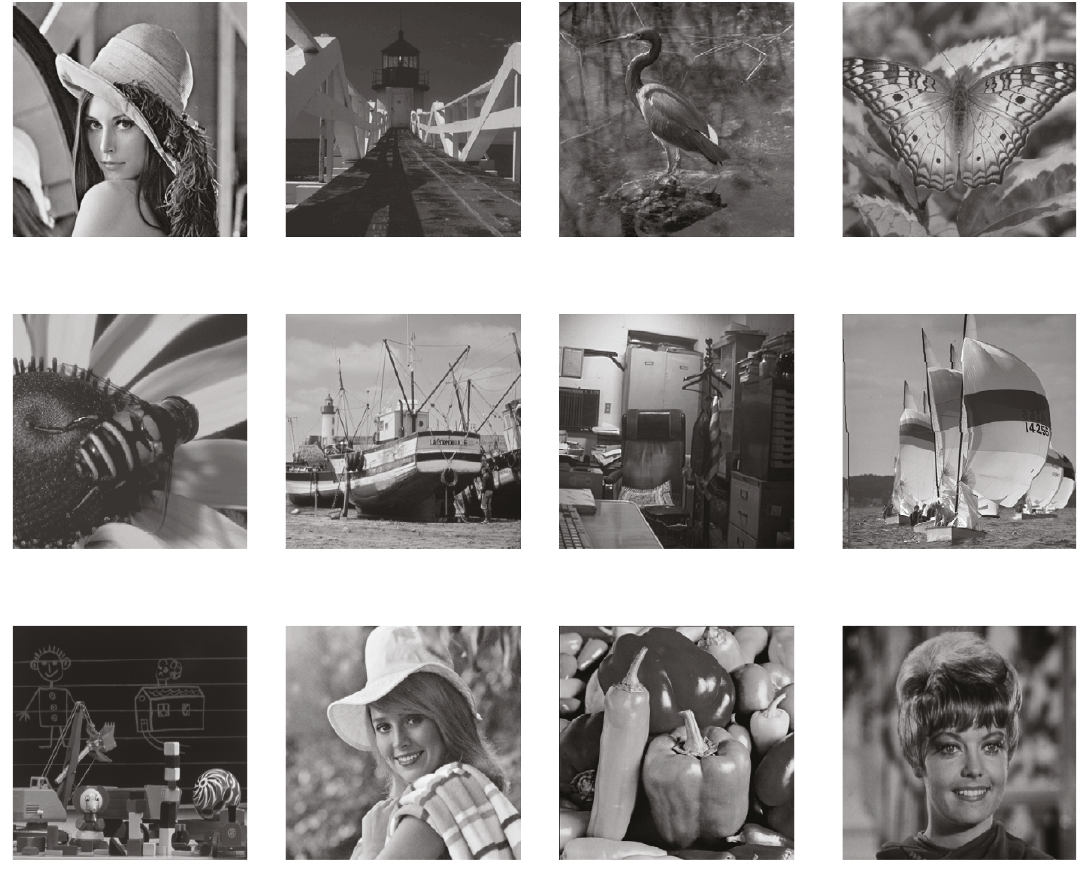
Figure 10: Image files in the test data set (TDS).